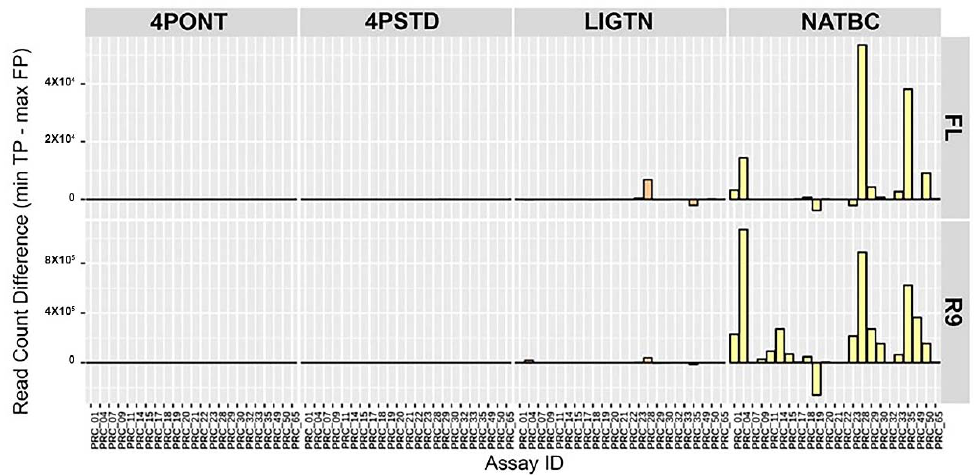
Figure 4. Spread between TP and FP aligned read count per amplicon. Difference between the minimum TP and maximum FP aligned filtered read count per amplicon reference. A larger positive number indicates a greater spread between these two values, and an overall lower FP rate for the assay. NTCs are not included.